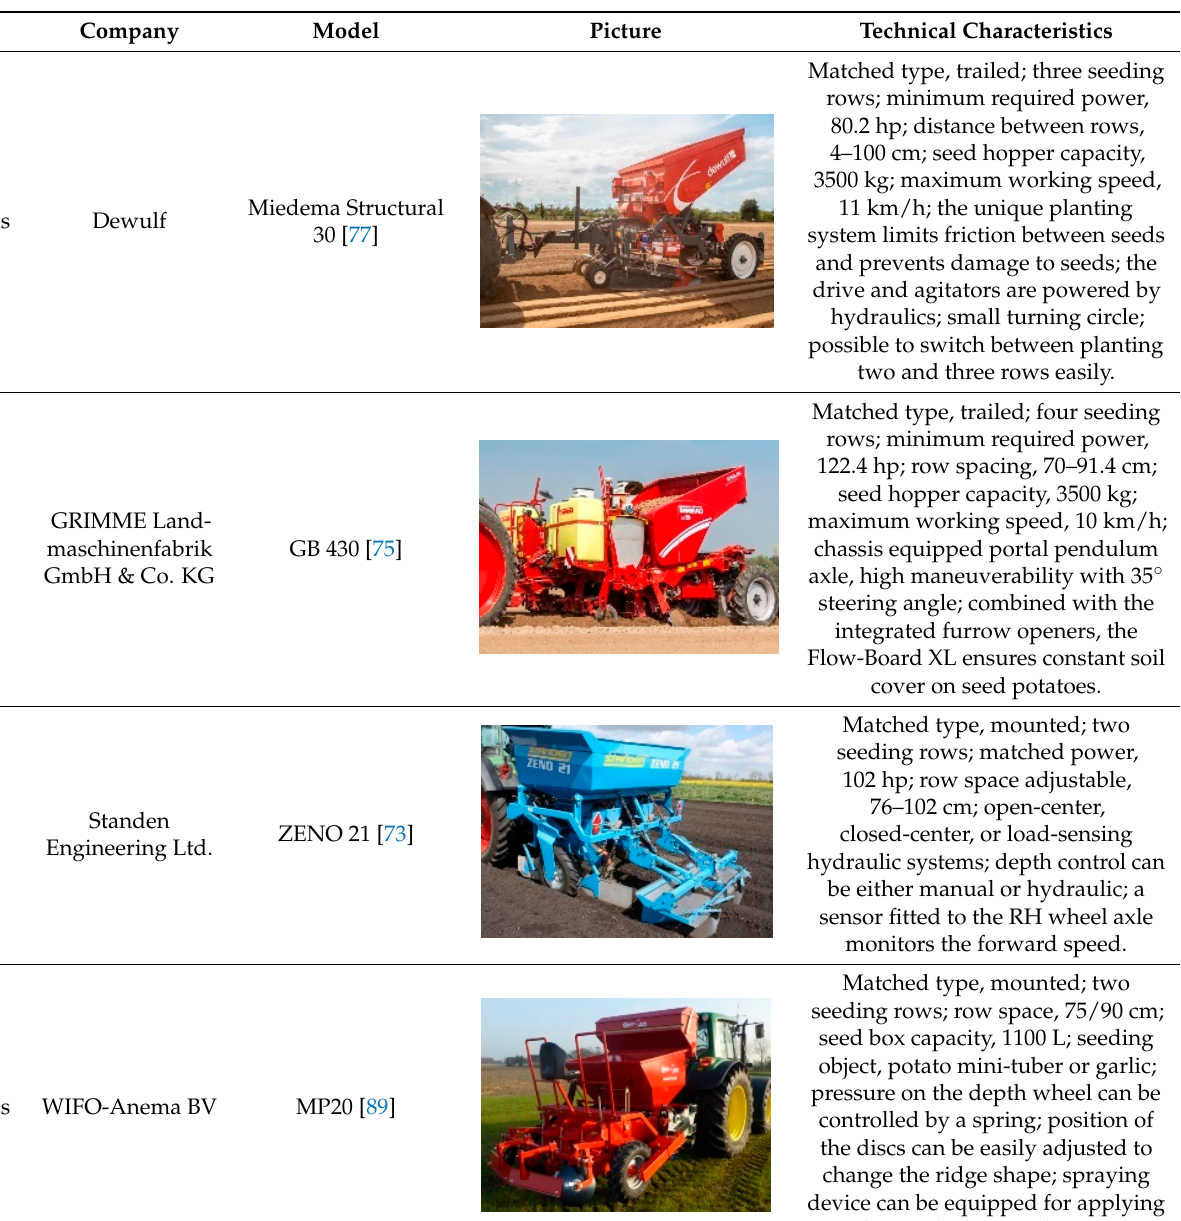
Table 5. Comparison of belt-type potato planters.